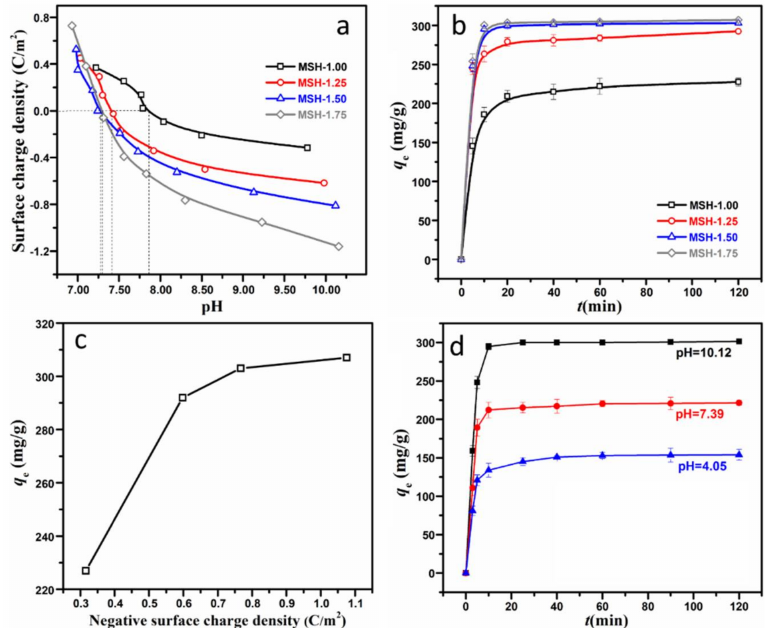
Figure 5. ( a ) Surface charge density of four MSH samples with different Si/Mg feeding ratio at different pH values; ( b ) equilibrium adsorption quantity of four MSH samples for MB; ( c ) the relationship between equilibrium adsorption quantity and surface charge density; ( d ) equilibrium adsorption quantity of MSH-1.75 sample at different pH